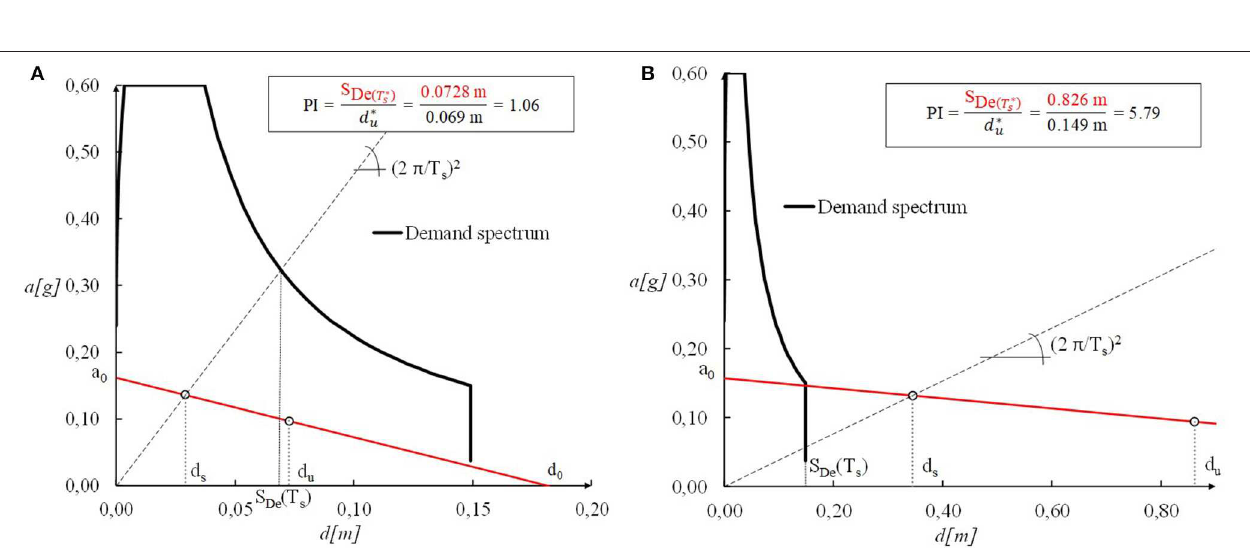
Frontiers in Built Environment |